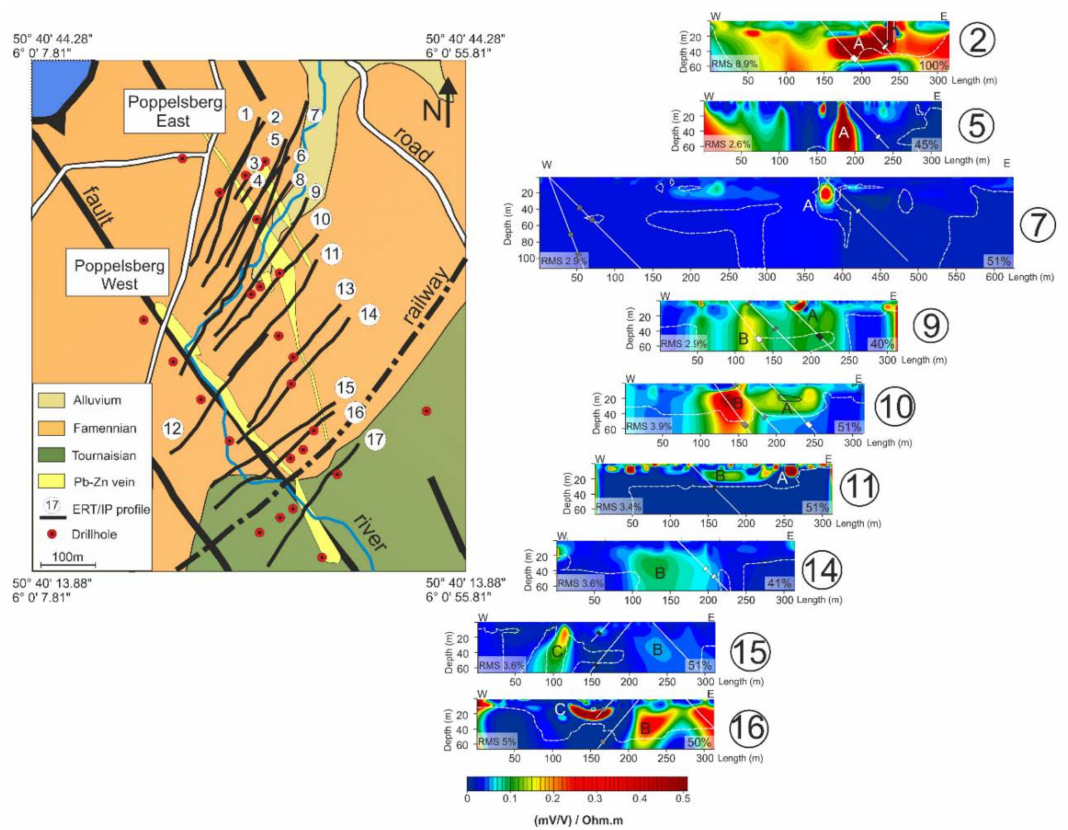
Figure 7. IP profiles (normalized chargeability) displaying drillings and mineralized area. Rectangles represent the thickness and location of the Pb–Zn mineralization. Colour of these rectangles indicate the distance of the drillings from the tomographic section, as follows: white rectangles: <10 m; grey rectangles: between 10 m to 20 m; and dark rectangles >20 m. The percentage on the right of each profile indicates the proportion of remaining data after data selection (see Figure 4). The white dashed lines represent the DOI limit corresponding to a value of 0.1. A, B, and C corresponds to the anomalies attributed to Pb–Zn mineralization (geological map modified from Laloux et al.